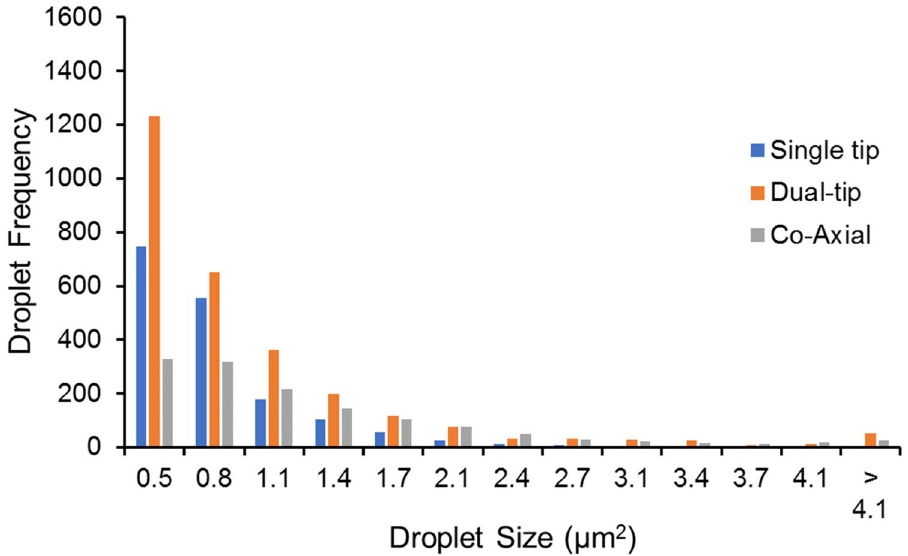
Figure 5. Droplet distribution for the three paper loading types. Each was sprayed on to an ITO coated glass slide at a distance of 5 mm and the central region of the slide was examined in each case to obtain the droplet distribution (see ‘Materials and Methods’).